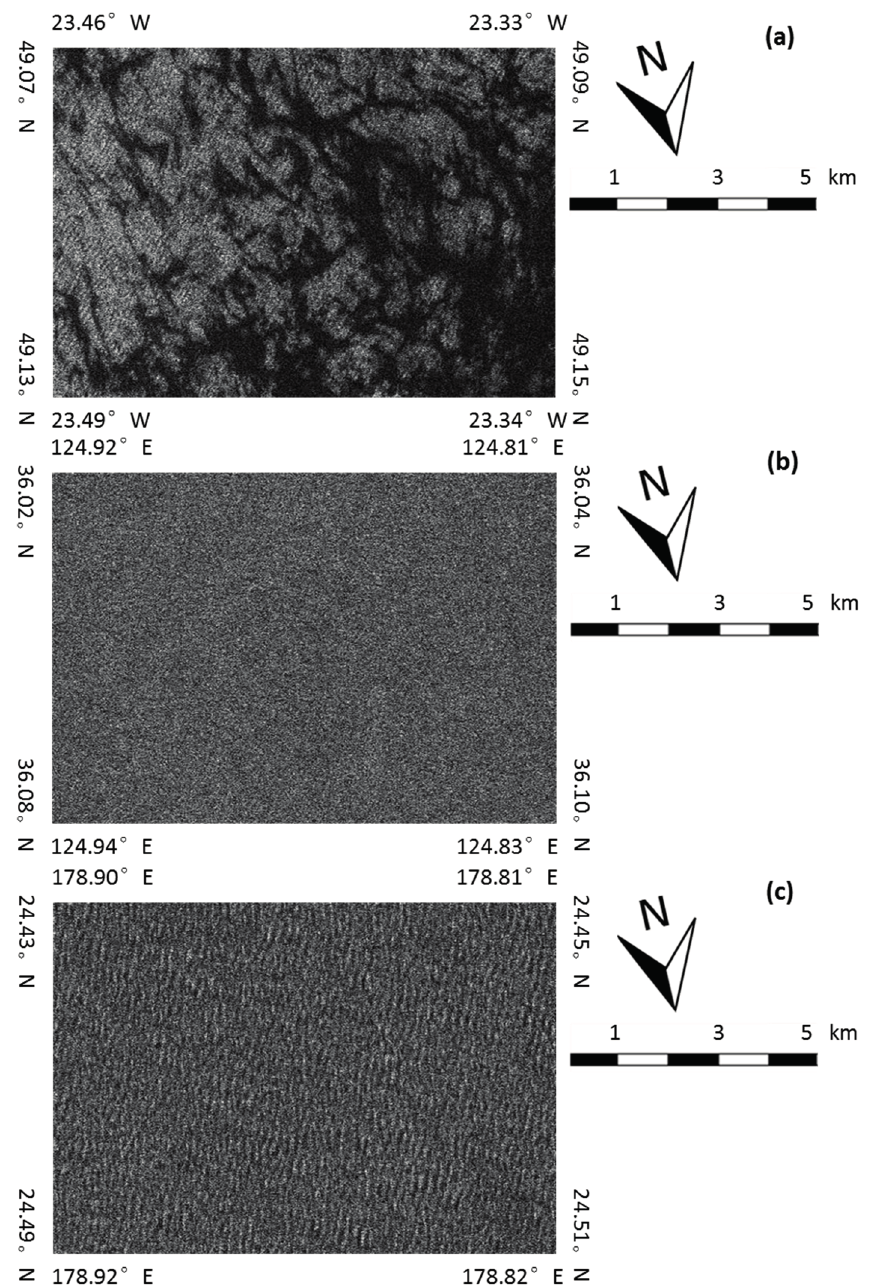
Figure 1. Envisat ASAR imagette acquired on ( a ) 01 August 2008 20:49:43; ( b ) 1 January 2007 01:52:24; and ( c ) 30 October 2008 22:08:29; with the image variance of 2.34, 1.02 and 1.30,